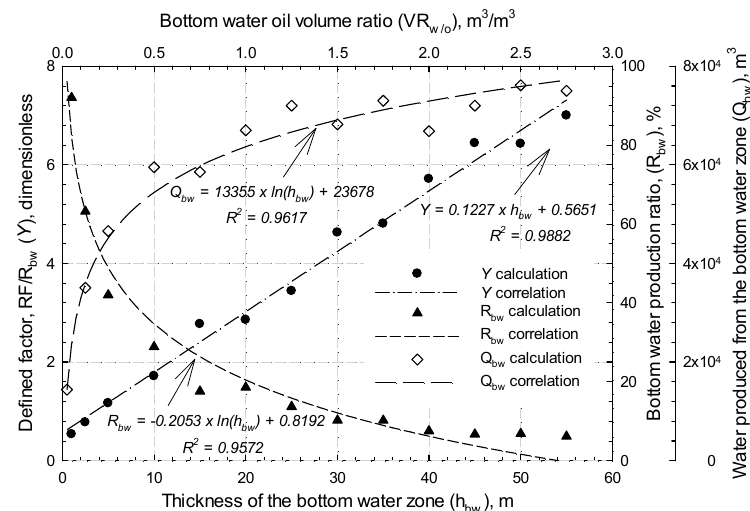
Figure 7. Simulation results and correction curves for the defined factor ( Y ), the water production ratio from the bottom water zone ( R bw ), and the volume of water produced from the bottom water zone ( Q bw ) under different thicknesses of the bottom water zone ( h bw ).